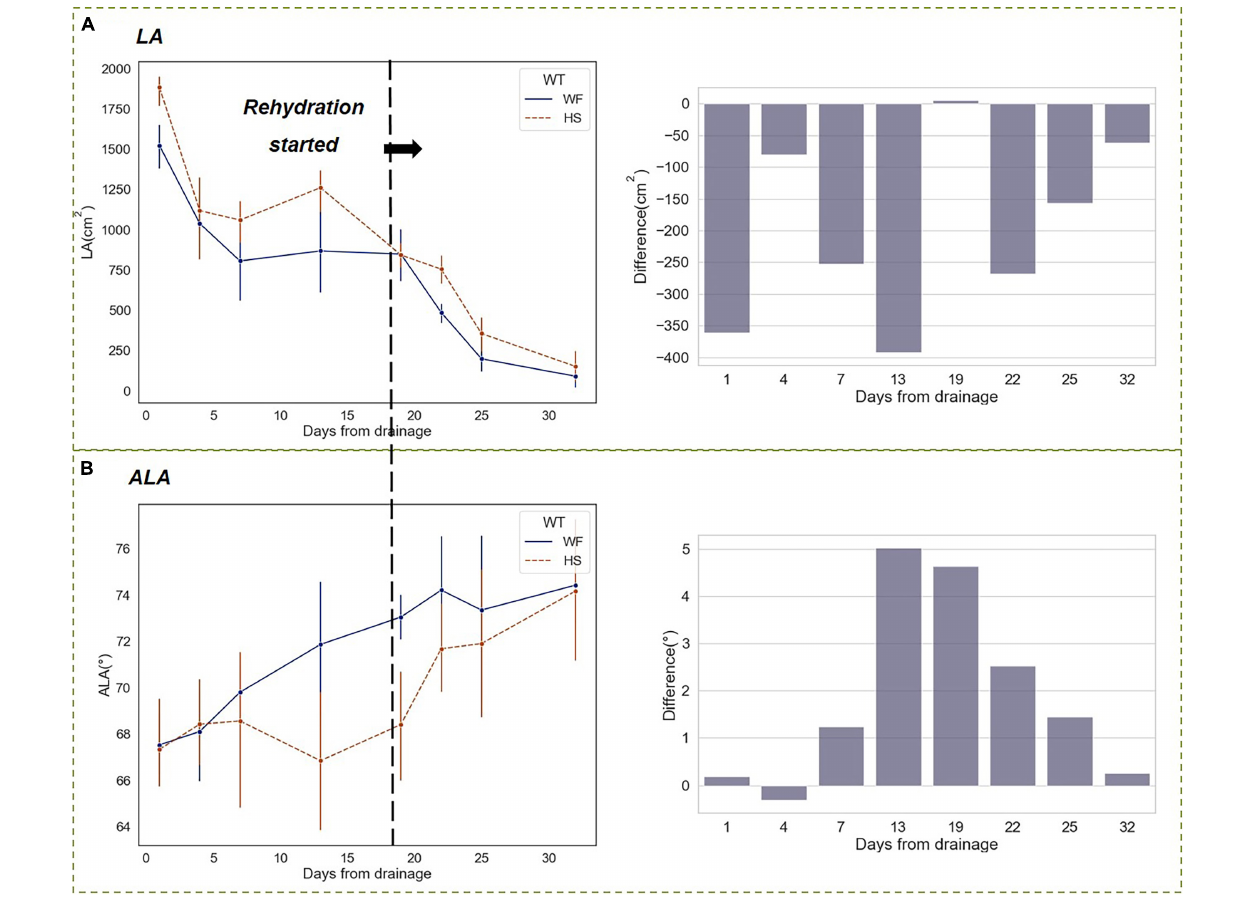
FIGURE 10 | Changing trends of phenotypic traits under short-term drought-rehydration at heading and filling stages. (A) Leaf area ( LA ). (B) Average leaf angle ( ALA ).